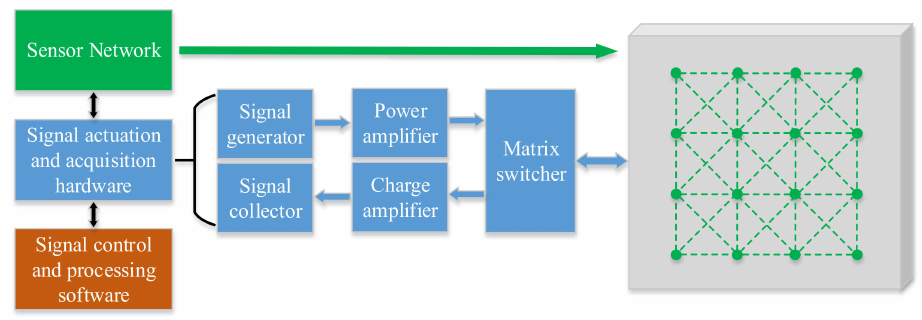
Figure 1. Components of an ultrasonic guided wave detection